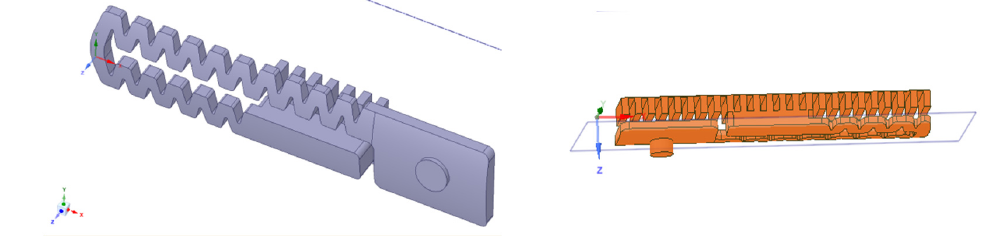
Figure 6. The fluid space of the drip irrigation channel.